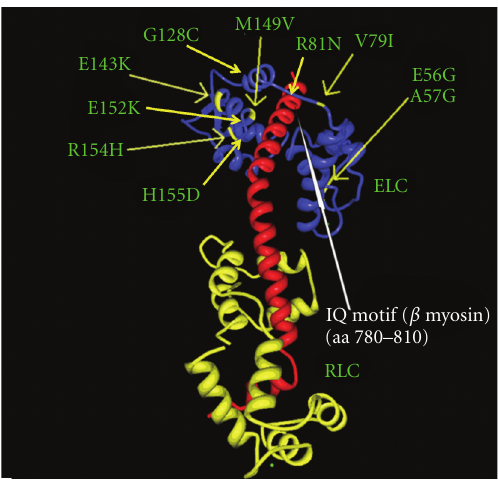
Figure 5: The location of the p.V79I mutation (arrow) in the three- dimensional structure of the regulatory domain of myosin (red) with the essential (ELC) (blue) and regulatory (RLC) (yellow) light chain. The other known mutations in ELC are also marked. It is seen that the p.V79I mutation; as well as the pR81H and p.M149V mutation, is located close to the IQ1 motif of the myosin helix. The IQ1 motif is marked by a white arrow. The figure is based on X-ray crystallographic structure of the myosin myosin regulatory domain of the scallop as given in the 1WDC pdb file